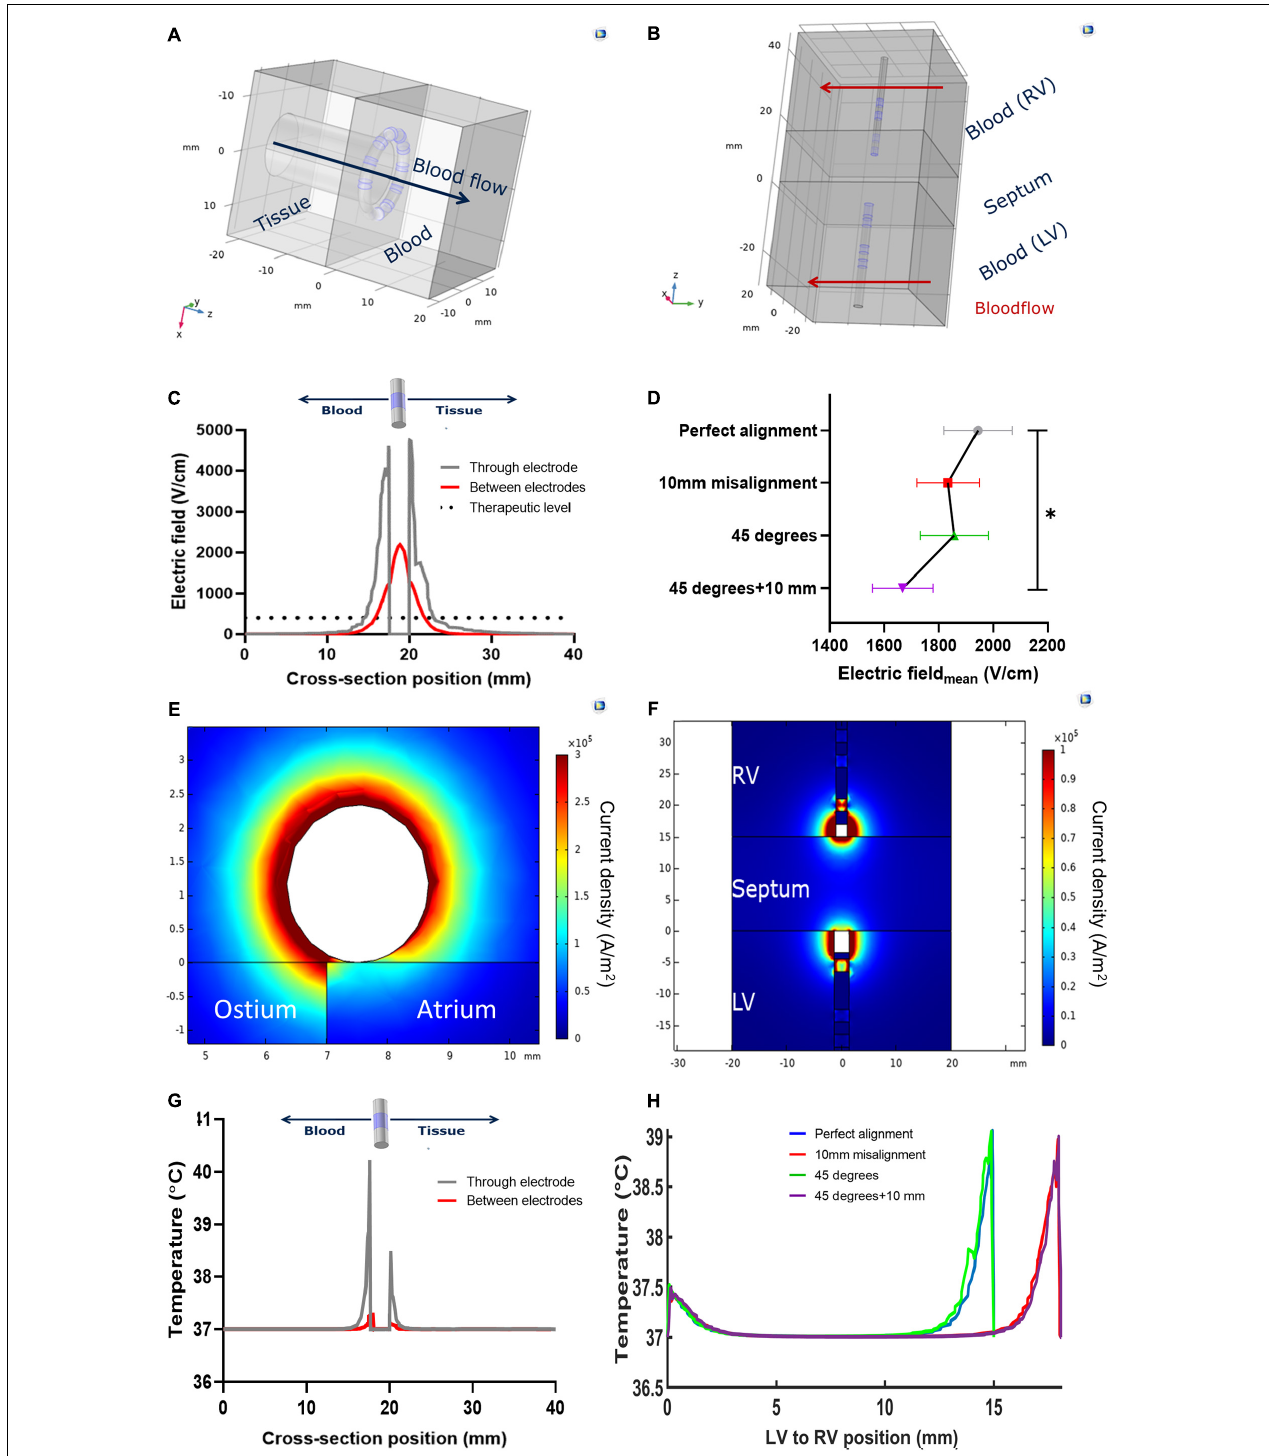
FIGURE 3 | Models and notable results of numerical simulations. (A) Geometry of the pulmonary vein ostium ablation; (B) Geometry of the interventricular septum ablation, with perfect alignment; (C) Electric field variation across the circular catheter used in the left atrium; (D) Average electric field across the interventricular septum, with respect to the relative linear misalignment or angular tilting (* p < 0.05); (E) current density profile in pulmonary vein ostium ablation; (F) current density profile in the interventricular septum ablation in perfect alignment; (G) Temperature profile across the circular catheter used in the left atrium; (H) temperature profile across the interventricular septum upon ablation, with respect to the relative linear misalignment or angular tilting.